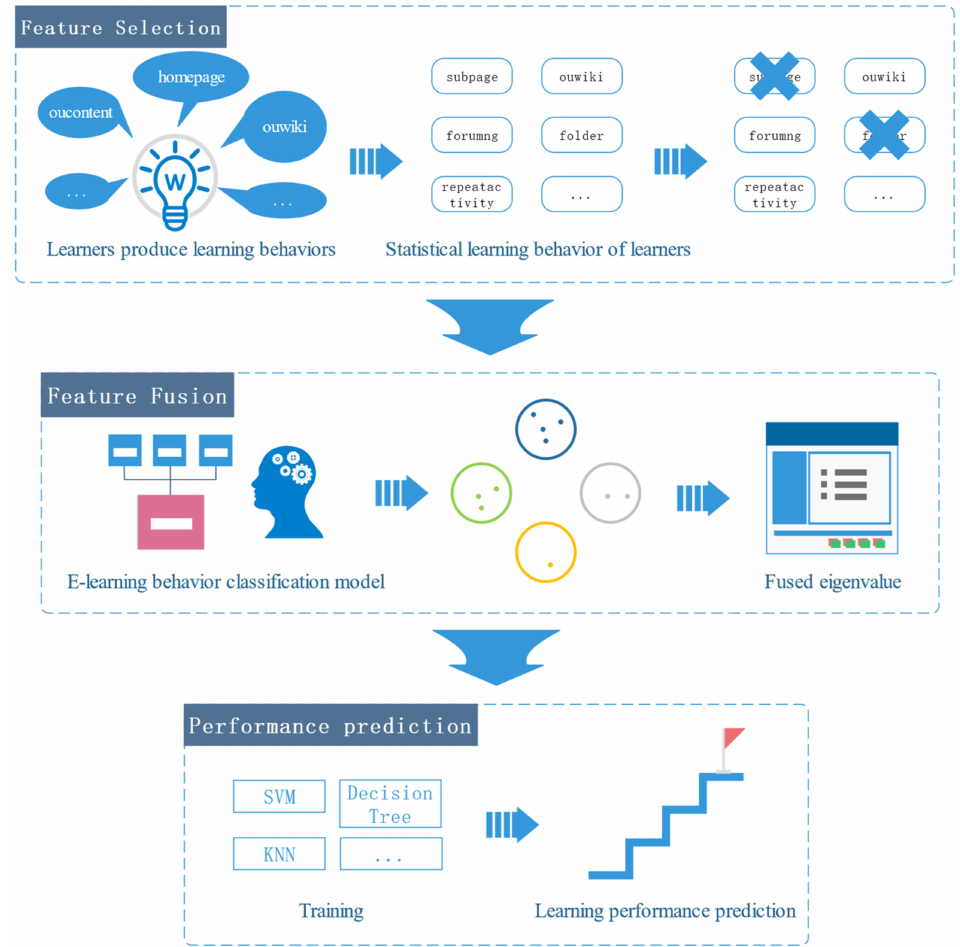
Figure 1. The process of self-adaptive e-learning performance prediction